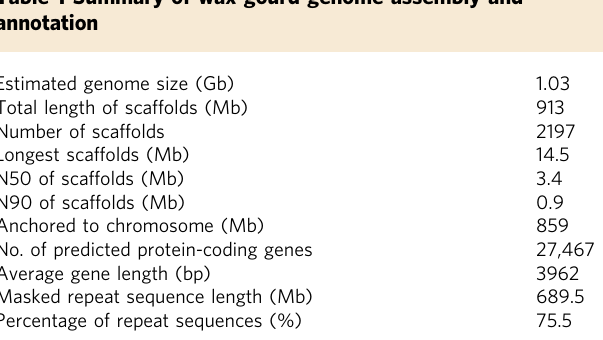
Table 1 Summary of wax gourd genome assembly